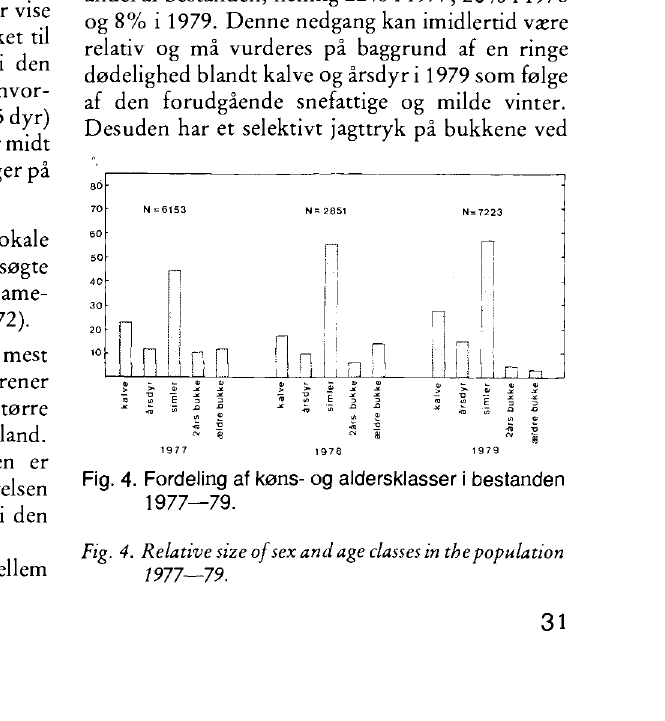
Fig. 3. Den gennemsnitlige flokstørrelse i hver sæson i rensdyråret. (Sæson-nr. henviser til omtalen side 00). Fig. 3. Average group size for each of the seasons in a caribou year. (Season no. refers to explanation p. 00).